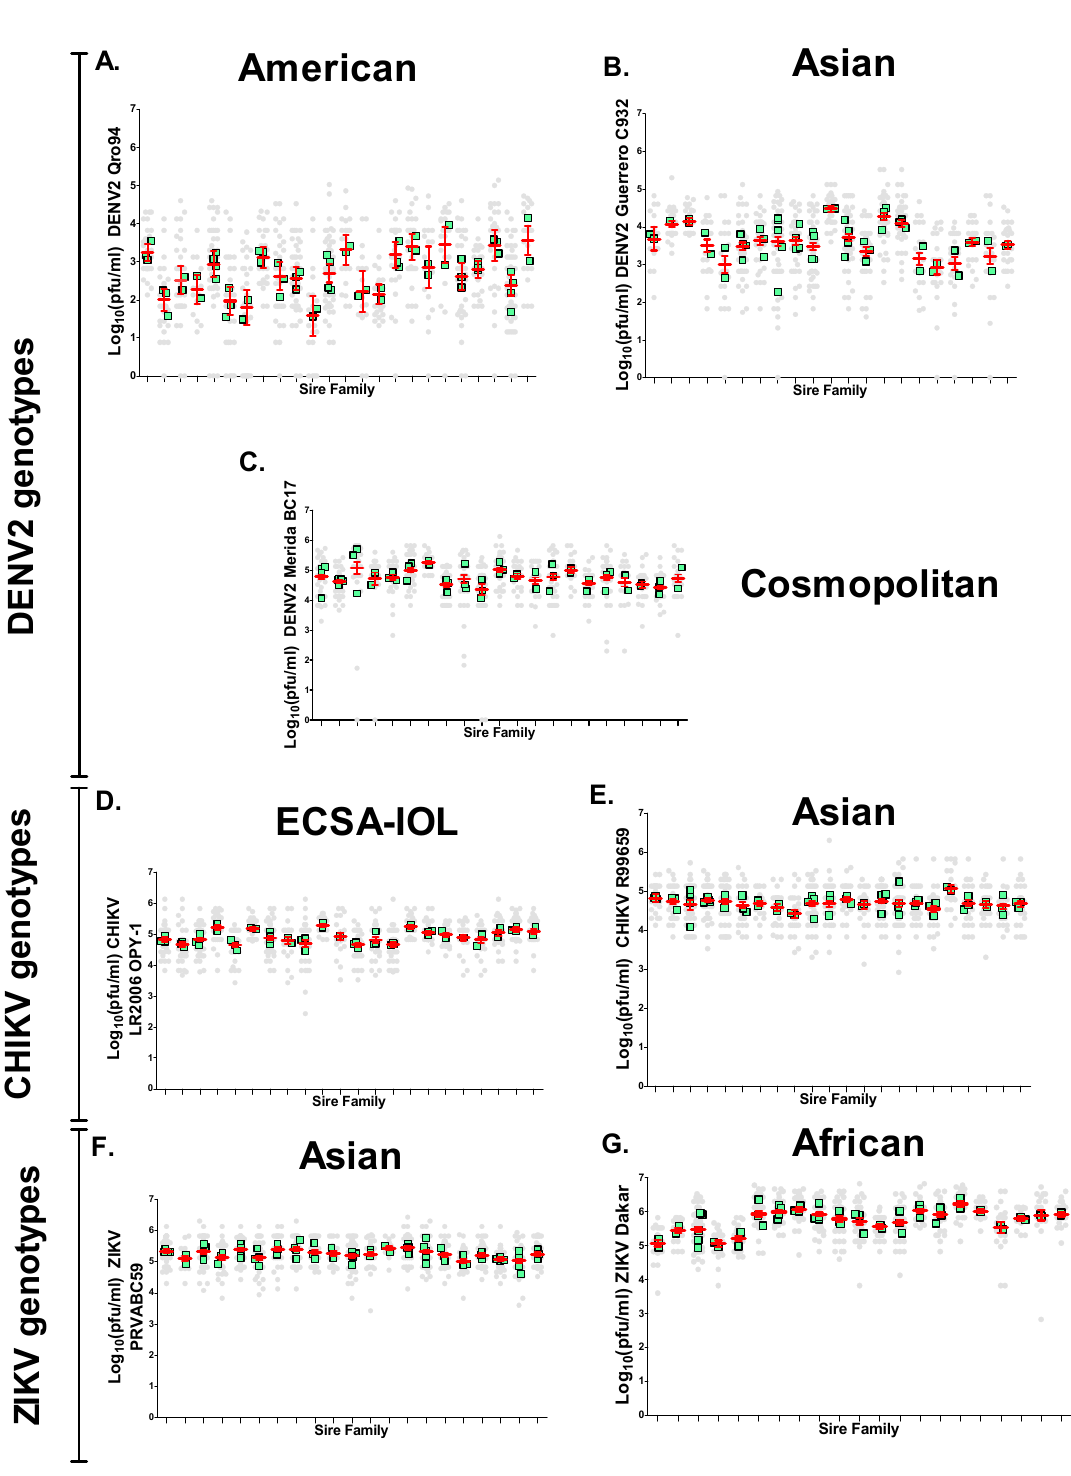
Figure 6. Distribution of phenotypes log 10 (PFU/mL) per salivary gland in half-sib families for the seven virus strains. Each column of points arising from the x -axis represents a sire family. In each column, the distribution of individual salivary glands titers arising from that sire appear as gray circles. Mean sire values and their 95% confidence intervals are displayed in red. The mean of dam families in each sire appear in green. ( A ) DENV2 American genotype, ( B ) DENV2 Asian genotype, ( C ) DENV2 Cosmopolitan genotype, ( D ) CHIKV ESCA-IOL genotype, ( E ) CHIKV Asian genotype, ( F ) ZIKV Asian genotype, and ( G ) ZIKV African